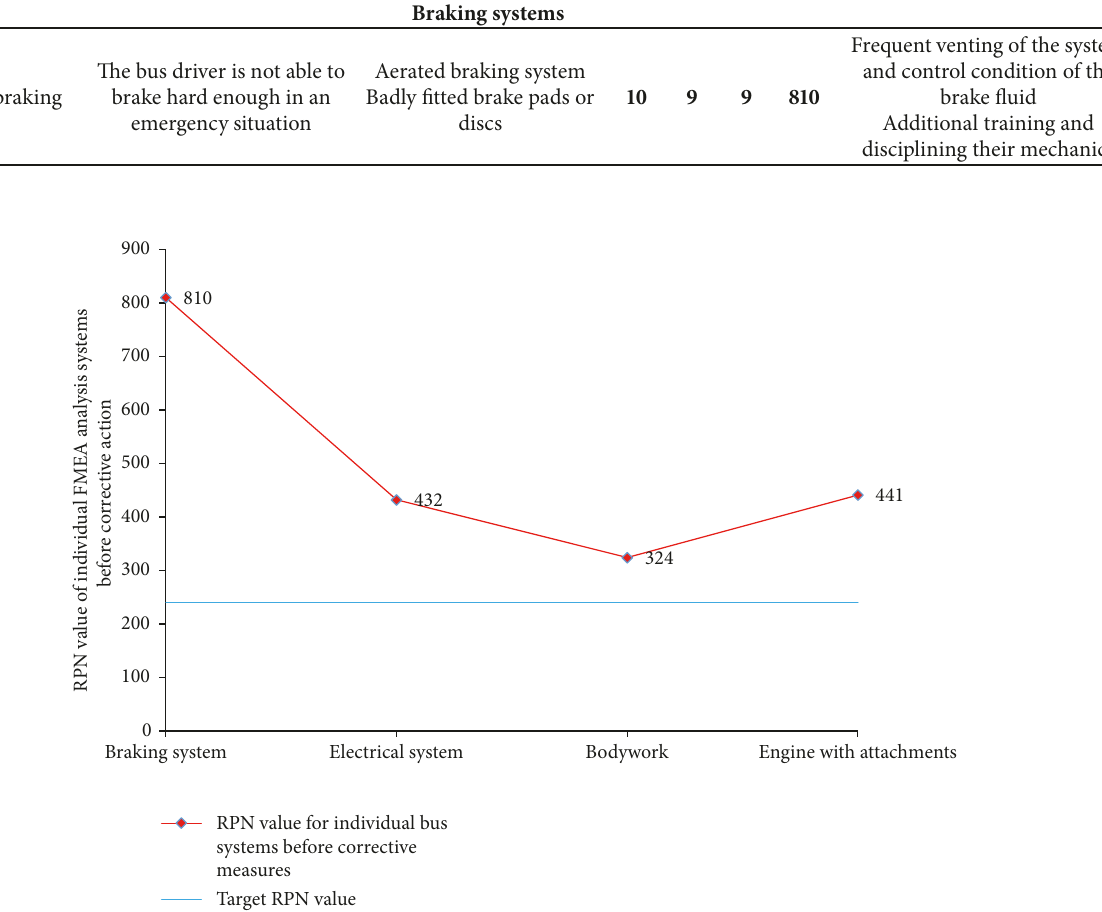
Figure 7: RPN value each of the bus systems before corrective action based on